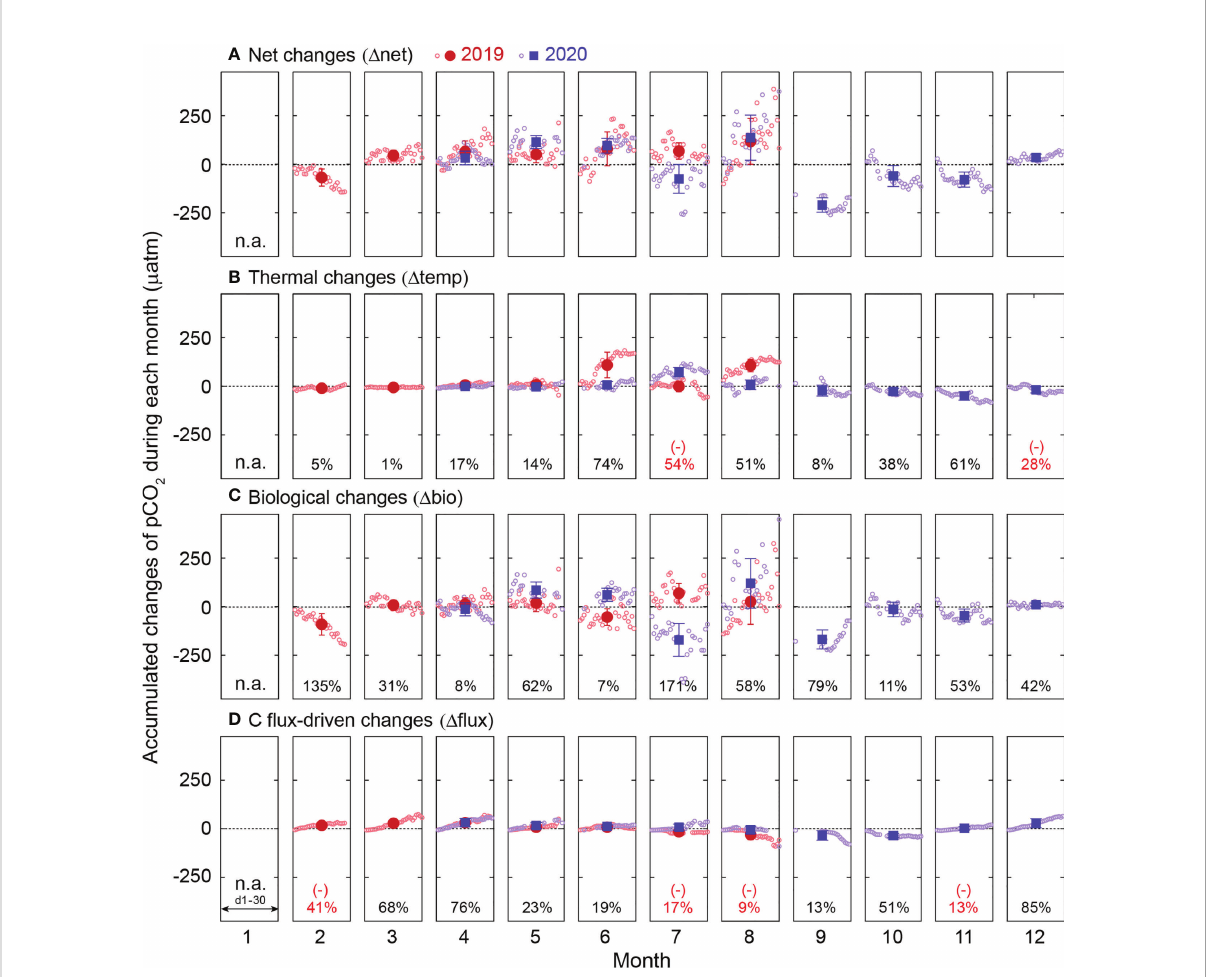
FIGURE 5 The monthly accumulated changes in pCO 2 from the beginning of each month driven by (A) all factors ( D net), (B) temperature ( D temp), (C) biological activity ( D bio), and (D) C fl ux ( D fl ux) during the continuous measurements in 2019 (red) and 2020 (blue). Open circles represent the accumulated hourly changes of pCO 2 . Filled symbols and error bars indicate the monthly mean values of the accumulated hourly changes during a month and the standard deviation of the daily means, respectively. The relative contribution (%) of each factor was derived from the proportion of the calculated two-year monthly mean value to that of the D net. Negative values (numbers in red) indicate the opposite direction of change to the D net. n.a. indicates 'data not